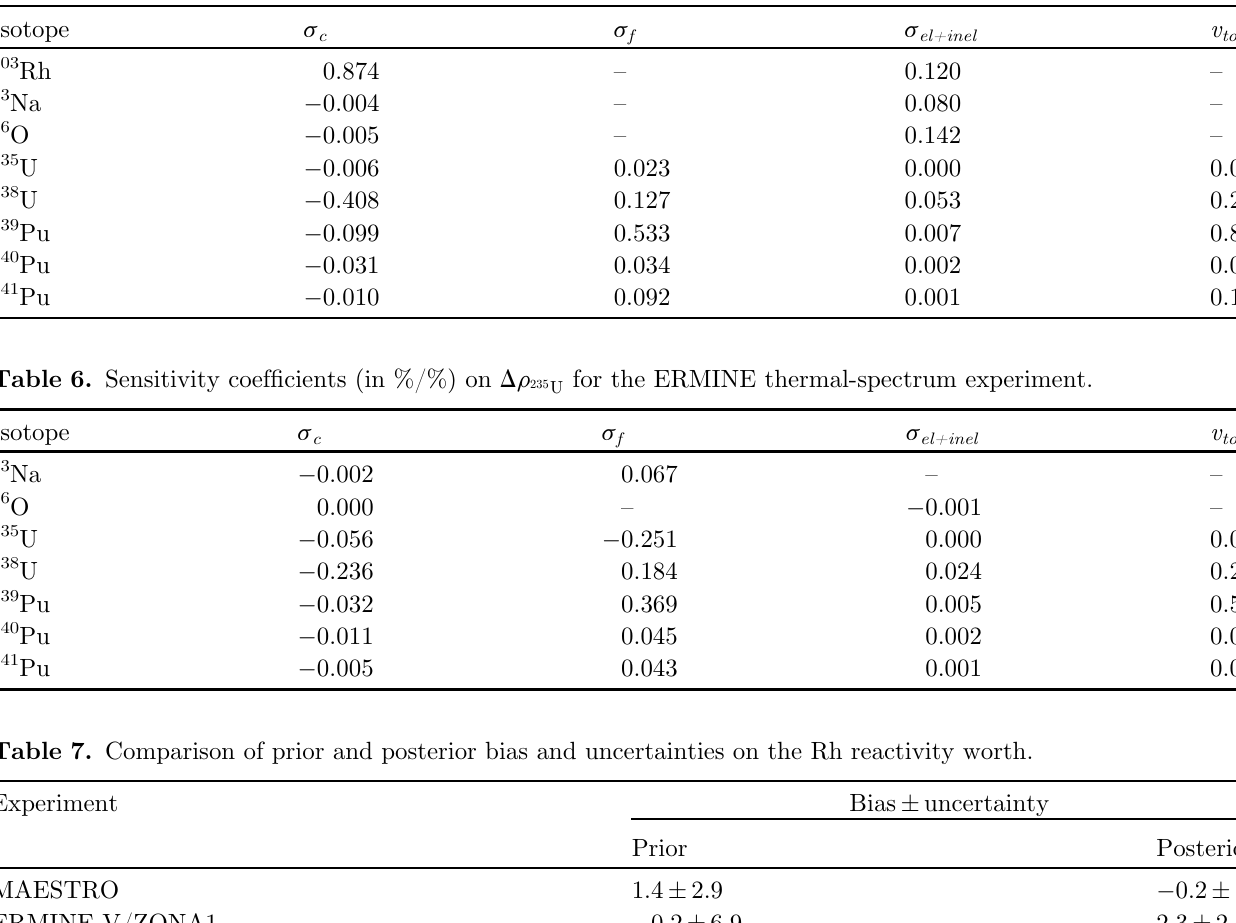
for the ERMINE thermal-spectrum experiment. Rh